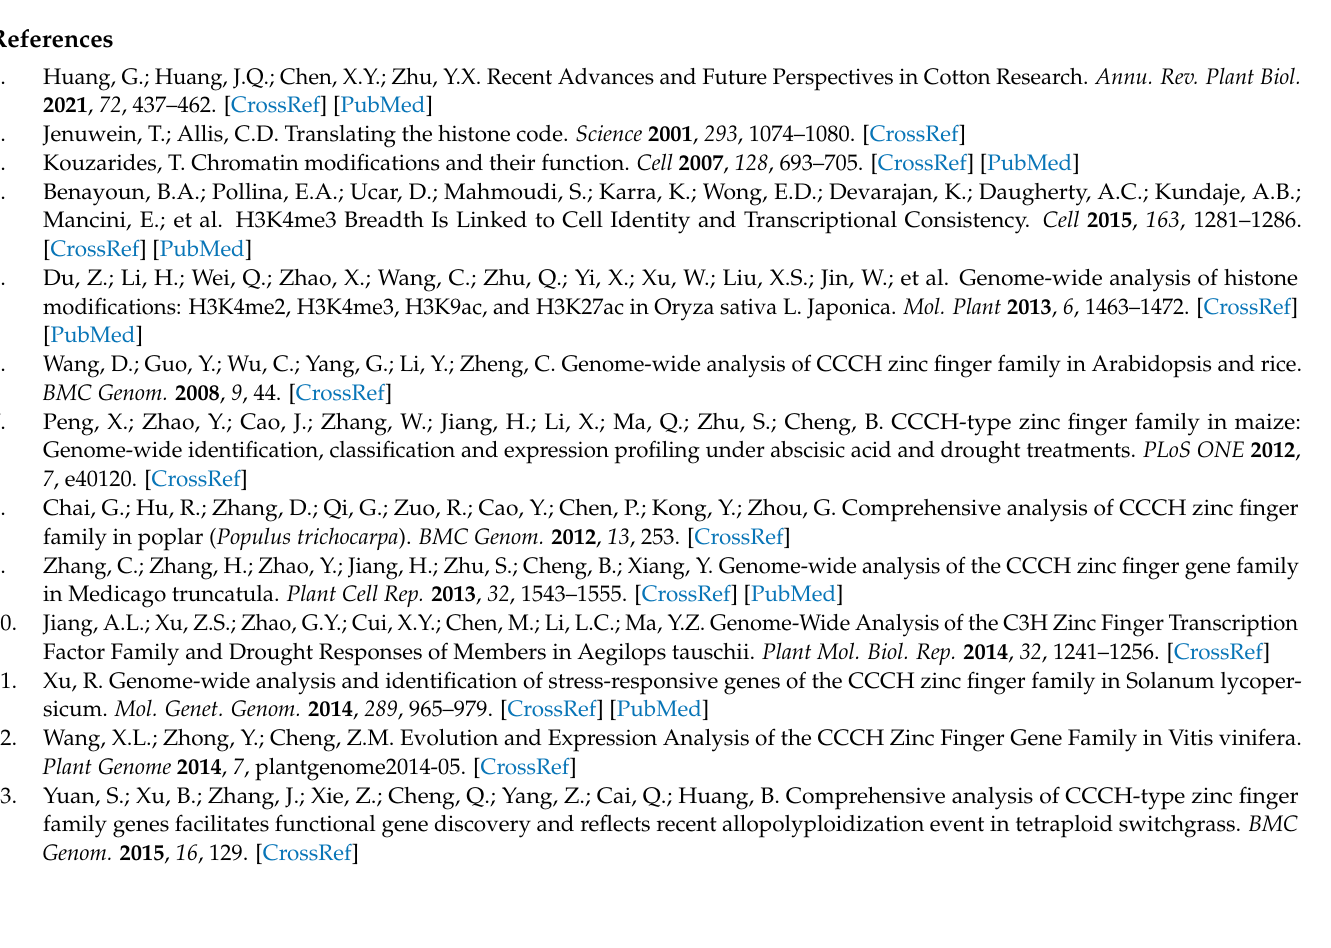
knockout lines; Figure S3: Plant phenotypes and seed/fiber weights of GhTZF2 -knockout lines; Figure S4: Verification of the transcription level of genes from RNA-Seq data via RT-qPCR; Table S1: CCCH family member numbers in reported plants; Table S2: Correlation of 3 replicates of WT and fl ChIP-Seq data against H3K4me3; Table S3: The mapping rates of ChIP-Seq sample; Table S4: WT-divergent genes on H3K4me3 level; Table S5: fl -divergent genes on H3K4me3 level; Table